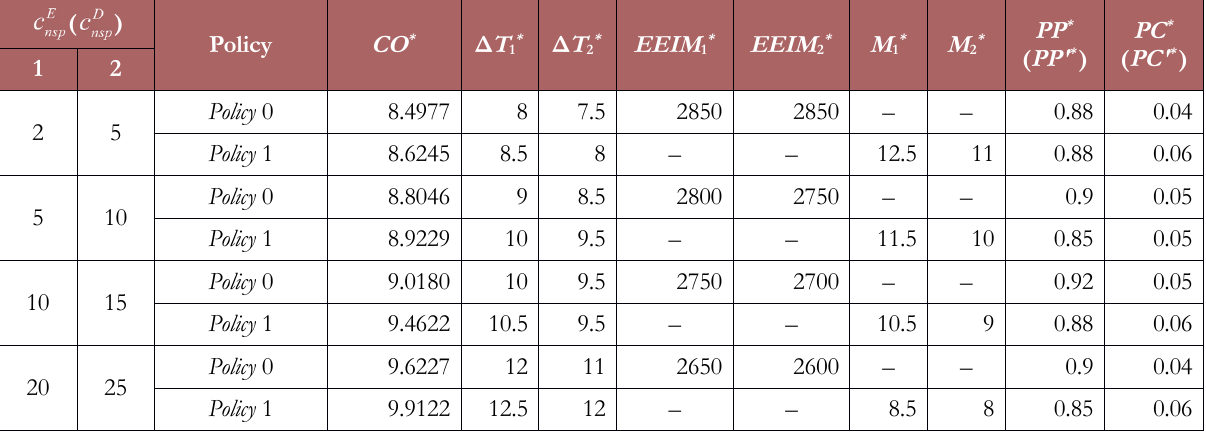
Table 4. CO * and optimal decision variables of two policies with different inspection